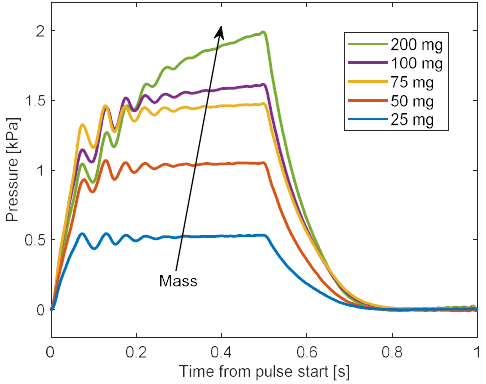
Figure 8. Pressure results during one pulse for different amounts.